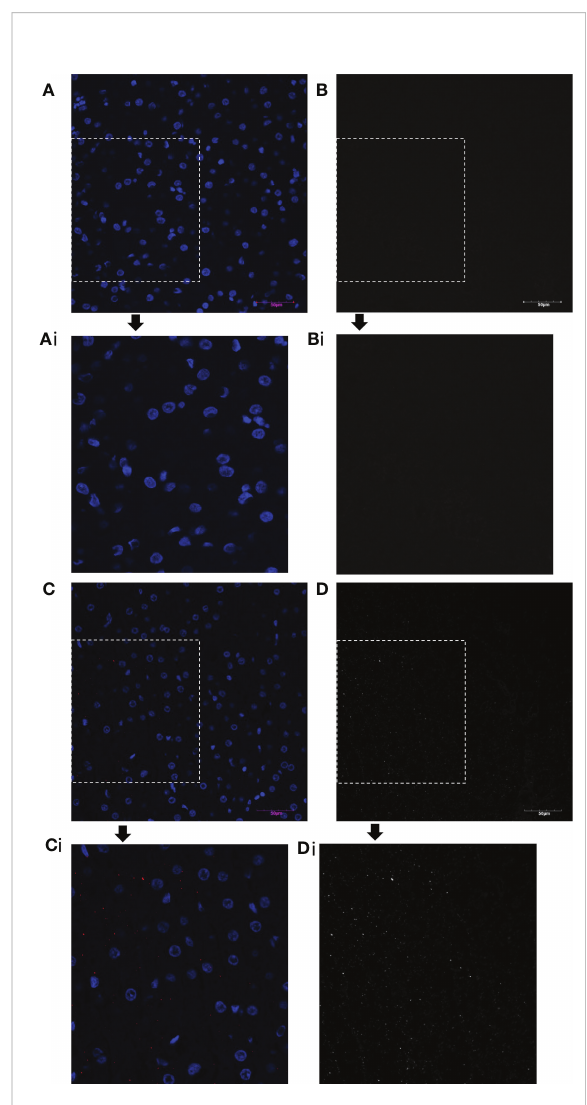
FIGURE 6 oFVIII-FLAG Immunohistochemistry Images of Liver Sections from a Control and a Treated Animal. (A) Representative images of the IHC staining of the liver from a control non-transplanted animal with an antibody to the FLAG-tag protein; (Ai) ampli fi ed inset area from A. (B, Bi) Same image as A and Ai but in black and white for better visualization after extracting the red channel and converting to grayscale in Photoshop. (C) Representative image of the IHC staining of the liver of treated animal with an antibody to the FLAG-tag protein (red); (Ci) ampli fi ed inset area from C. (D, Di) Same image as C and Ci but in black and white for better visualization after extracting the red channel and converting to grayscale in Photoshop. All images were acquired with an Olympus BX63 microscope Olympus with a 20x